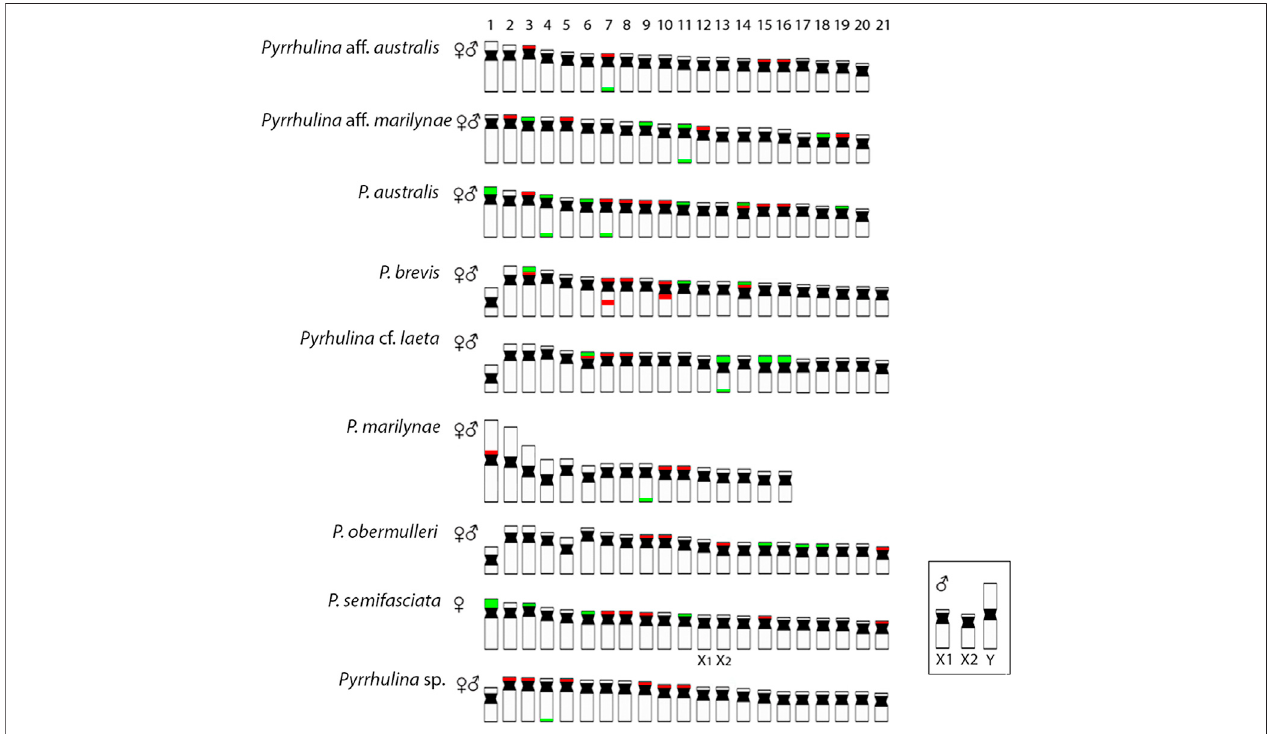
FIGURE 6 | Representative idiograms of Pyrrhulina species showing the distribution of the 18S (green) and 5S rDNA (red) sites on chromosomes, based on the present study and some other previous data (de Moraes et al., 2017; de Moraes et al., 2019). Bar (cid:1) 5 μ m.